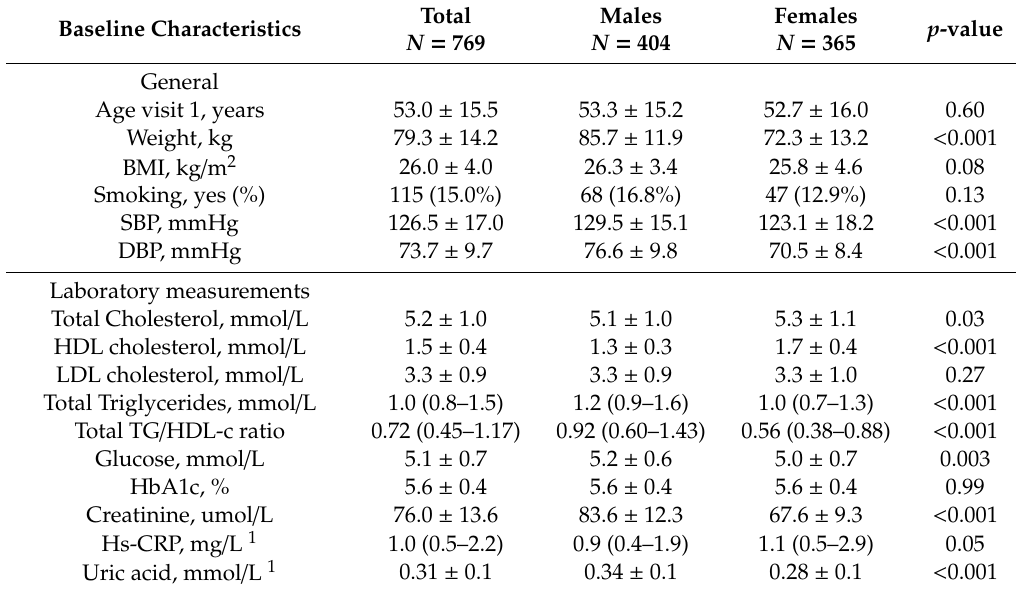
Table 1. Characteristics of the total Lifelines Population, separate for males and